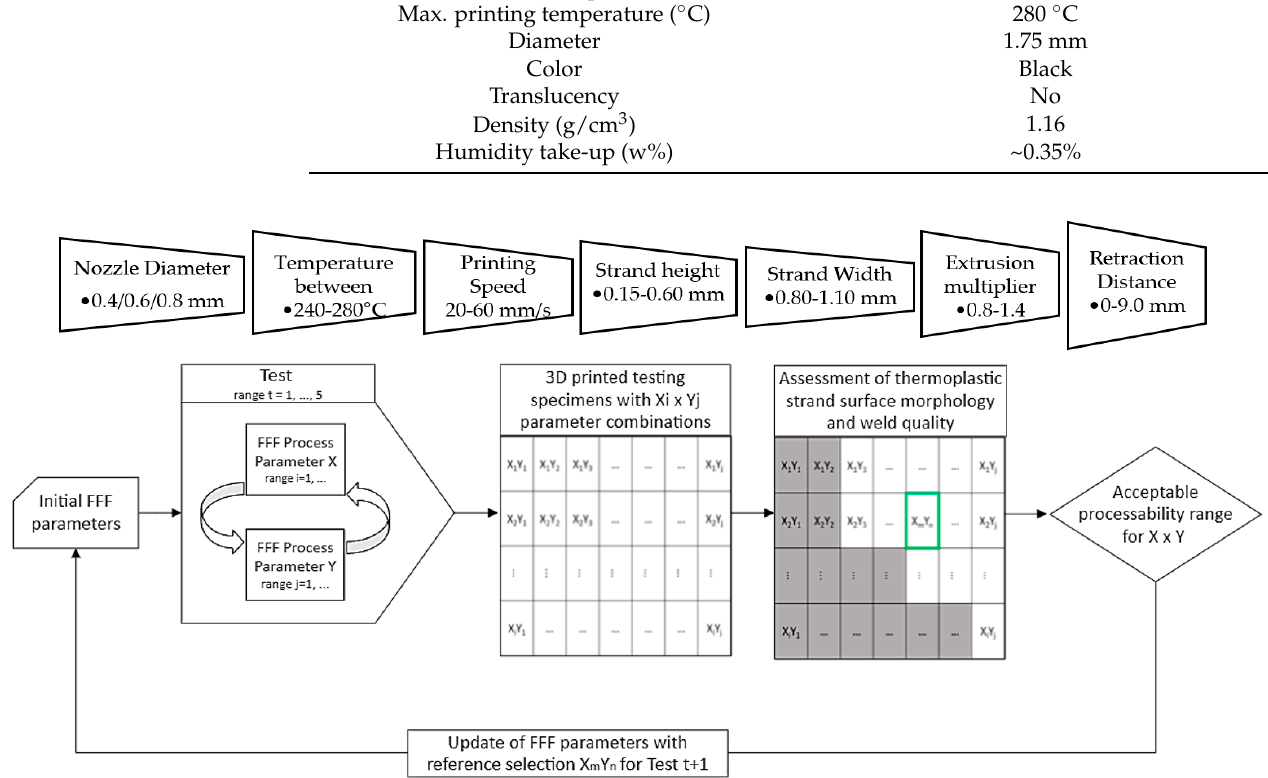
Figure 2. FFF Processability optimization path.